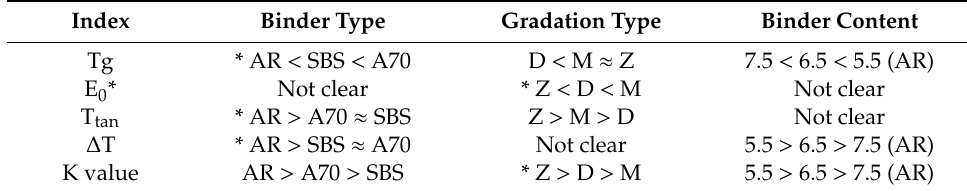
Table 3. Summary of the